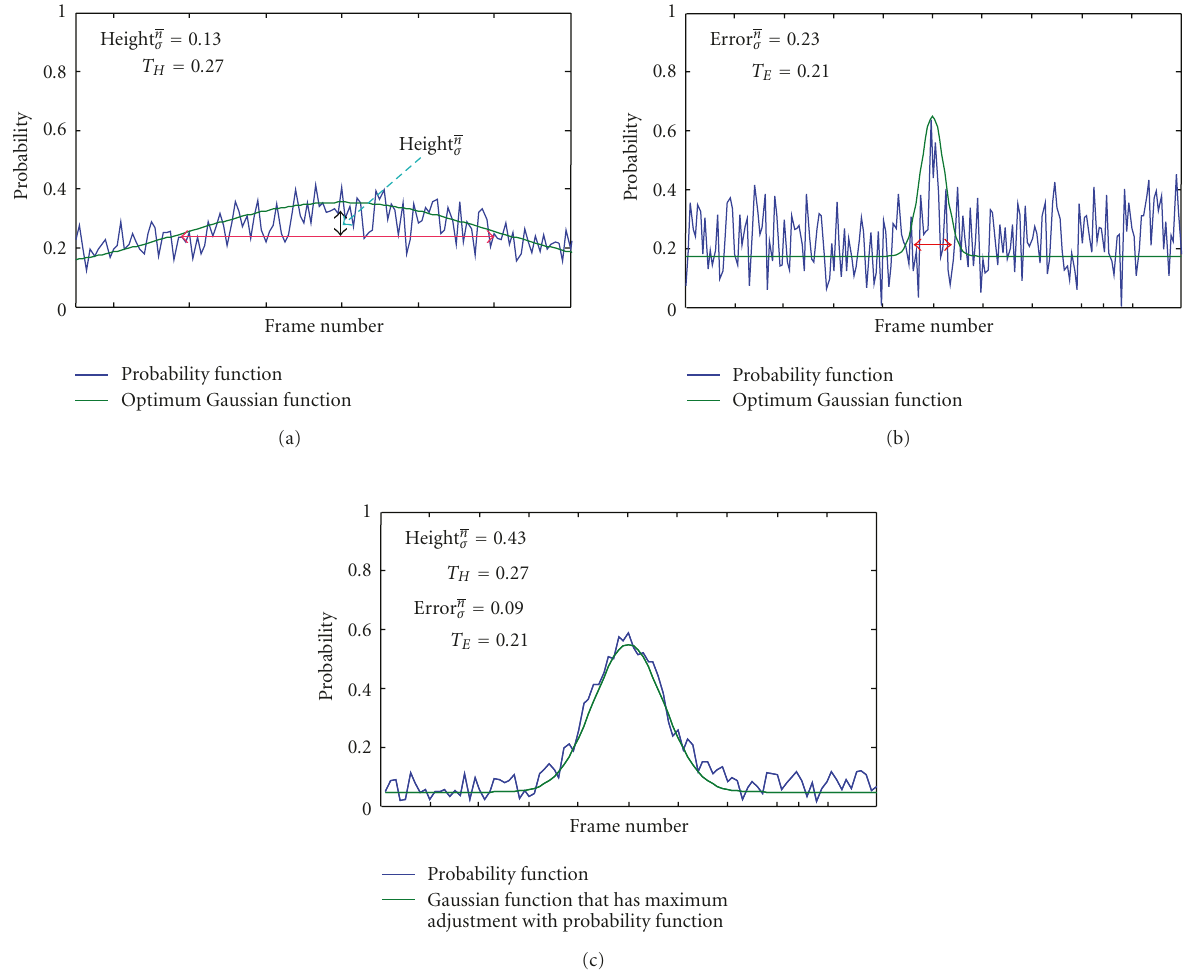
Figure 3: Examples of the detected candidates for gradual transitions, and finding the correct gradual transitions: (a) as Height n an incorrect gradual transition. (b) As Error n